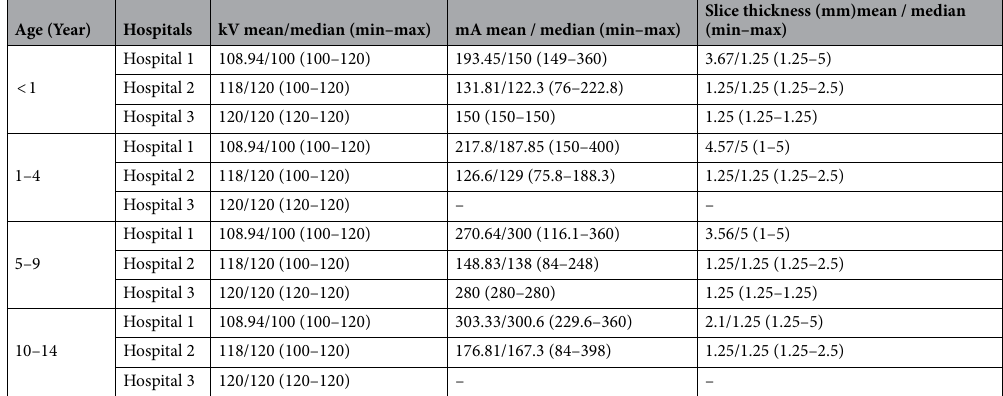
Table 1. Protocol acquisition parameters for the three scanners used.